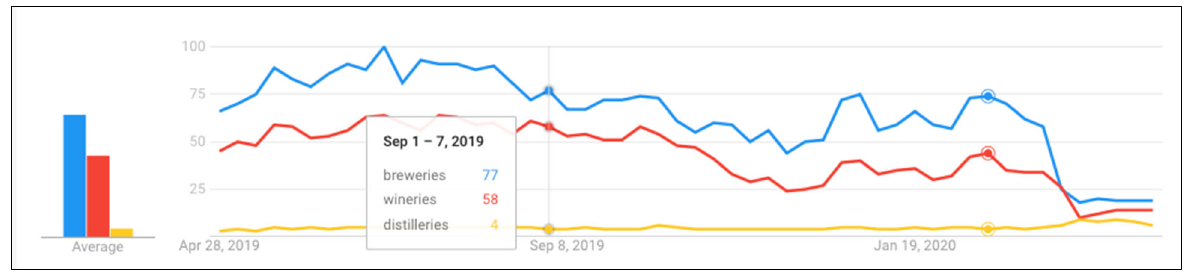
Figure 5a. Search Intensity for Breweries, Wineries, and Distilleries